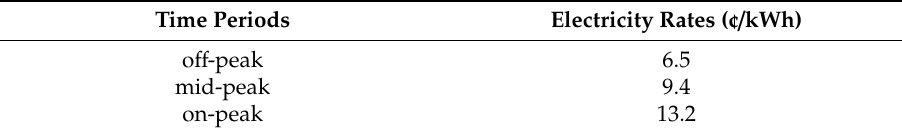
Table 4. Present time-of-use electricity rates [44].